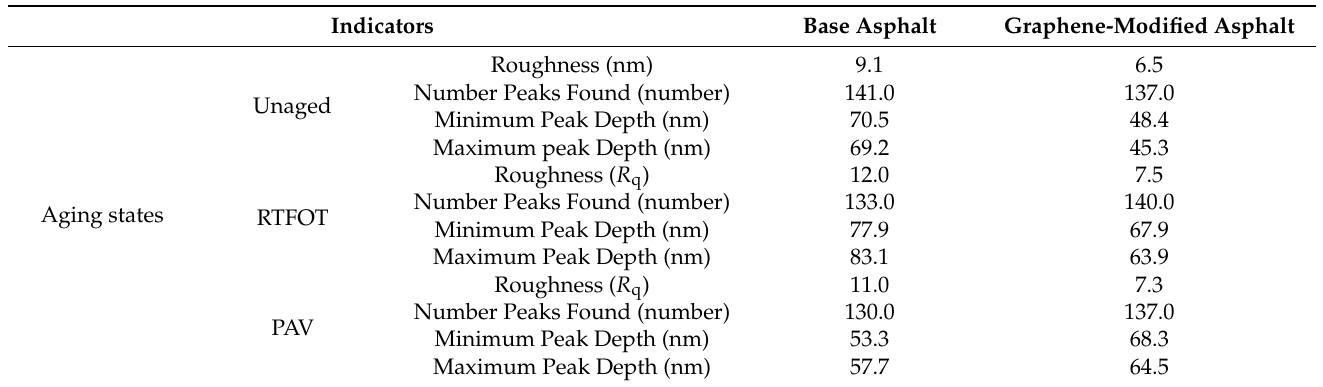
Table 1. Basic data parameters extracted from the 3D AFM topographies.